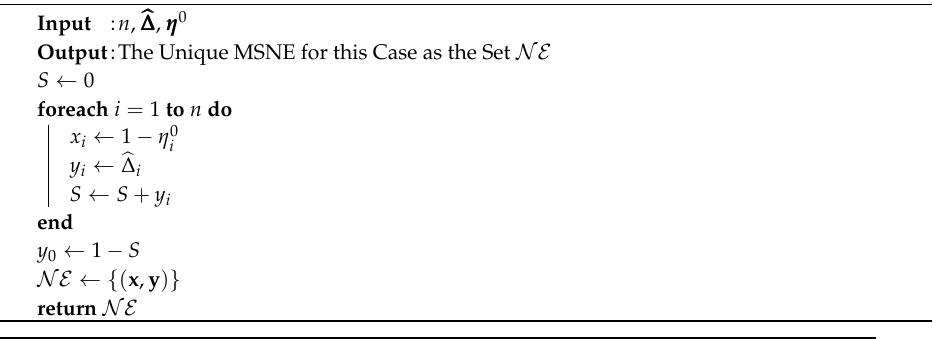
Algorithm A3: Subroutine to Compute (a Simple Linear Representation of) All MSNE of a Fully Transfer-Vulnerable Single-Attack IDD Game with ∑ n i = 1 (cid:98) ∆ i = 1.